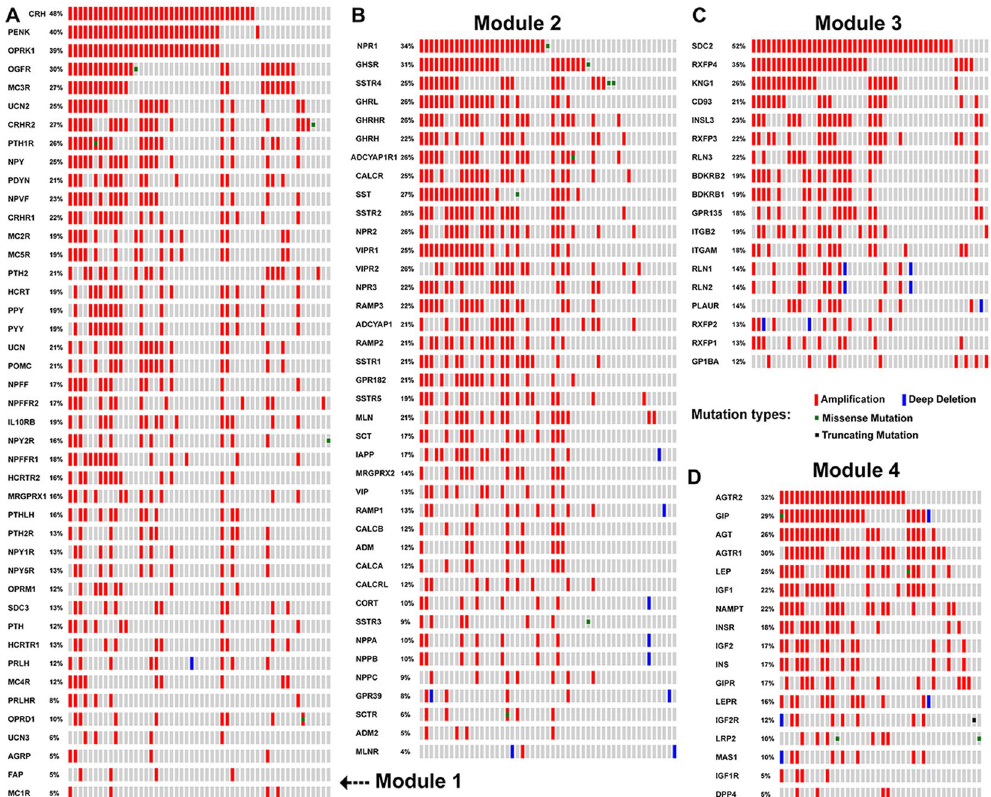
Figure 5. Somatic mutational patterns in neuroendocrine prostate cancer for the four modules. The sample- based mutational map for module 1 ( A ), module 2 ( B ), module 3 ( C ), and module 4 ( D ). The different mutational types are marked using different colours. The mutational types in ( A–D ) were depicted by colours. The red and blue represent the amplification and deep deletion respectively. The green and black dots are missense and truncating mutations respectively. The grey represents no mutations in the